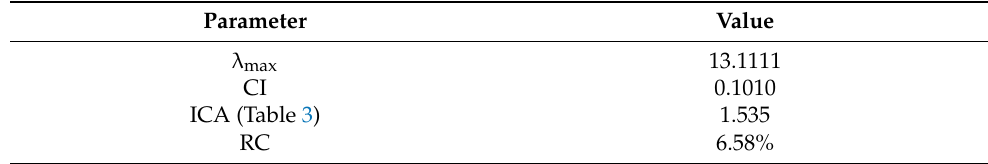
Table 8. Results of the consistency analysis of the normalized matrix (first